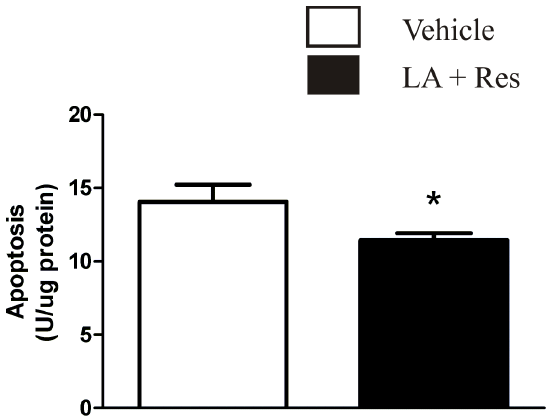
Figure 5. Effect of lipoic acid and resveratrol combination on a marker of apoptotic cell death. Bar graph of the quantified cytoplasmic histone-associated-DNA fragmentation (an indicator of apoptotic cell death) as obtained from a tissue sample (see methods for detailed description). Each bar represents the mean 6 S.E.M. and * indicates significance ( p # 0.05) from the vehicle-treated (propylene glycol 4 6 10 2 3% (v/v)) control group.